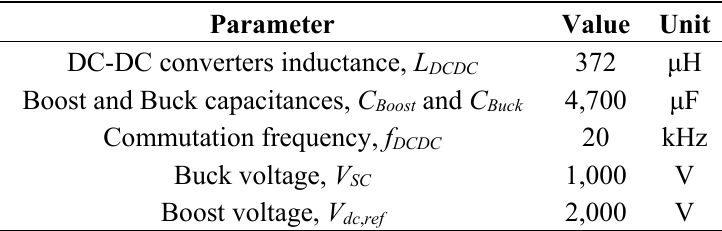
Table A7. DC-DC converter ratings.